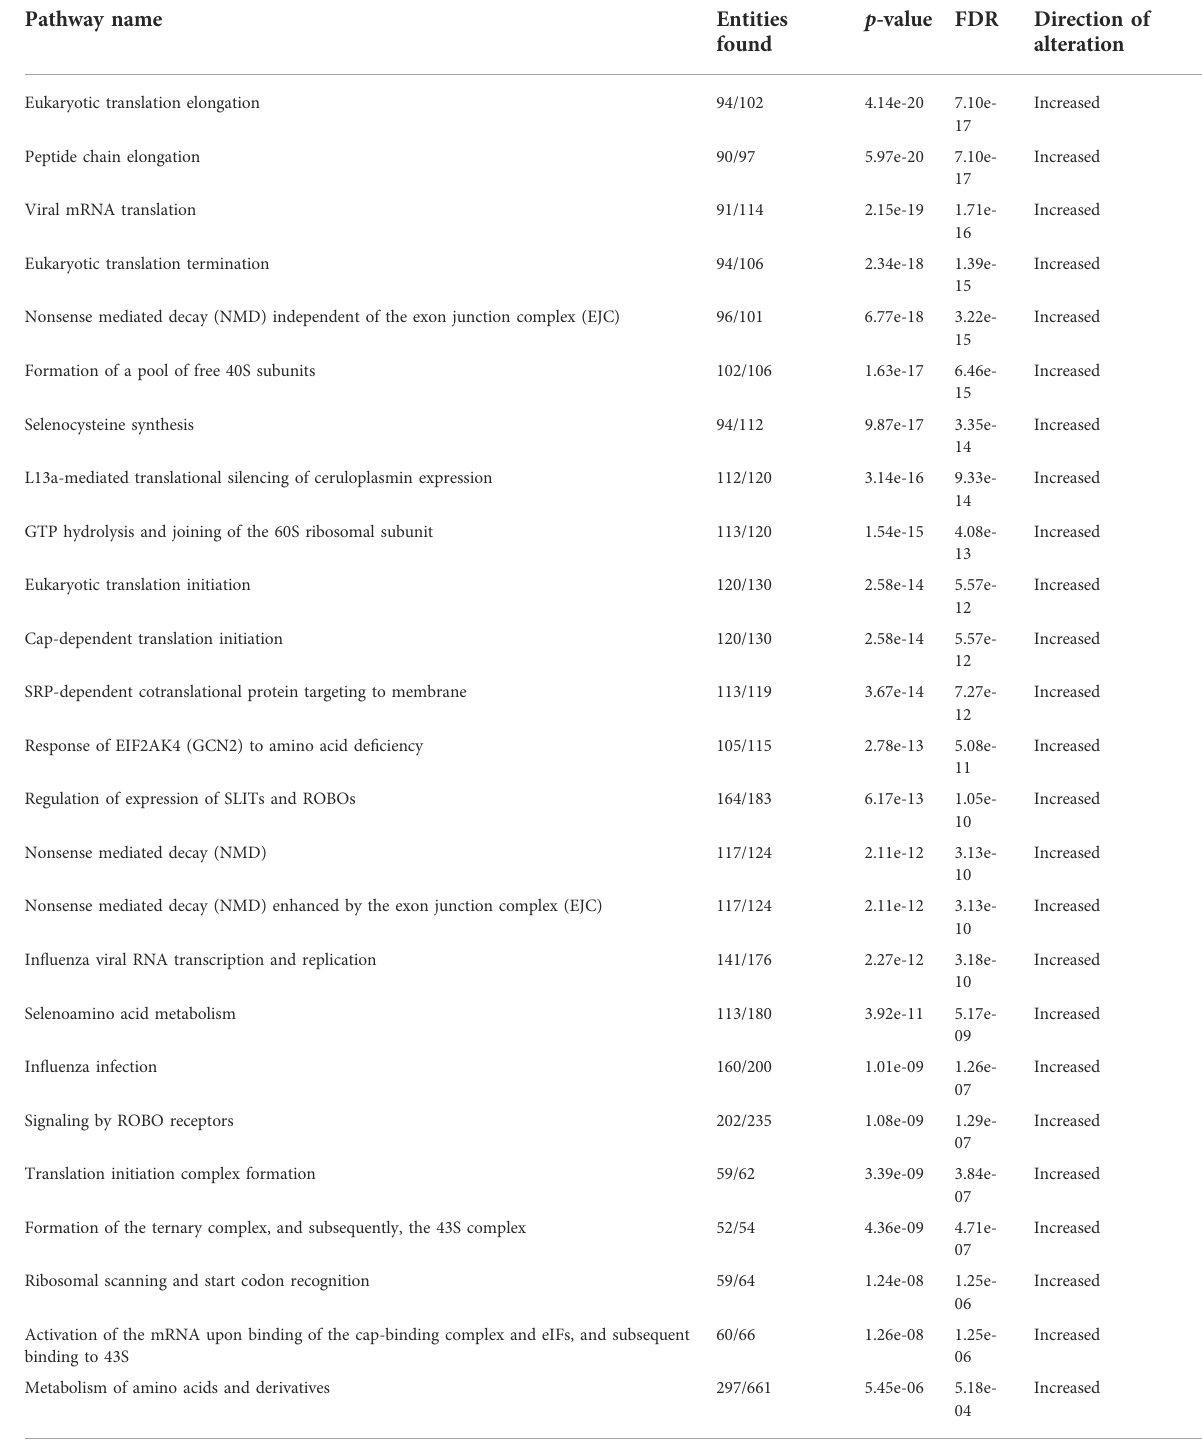
TABLE 5 RNAseq pathway analysis of SCM vs. RPMI (All cell lines